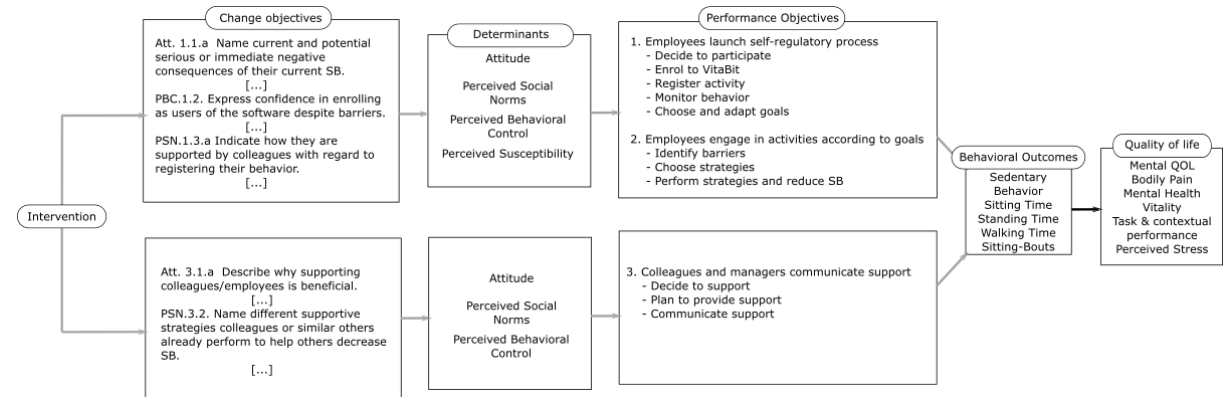
Figure 4. Illustration of the logic model of